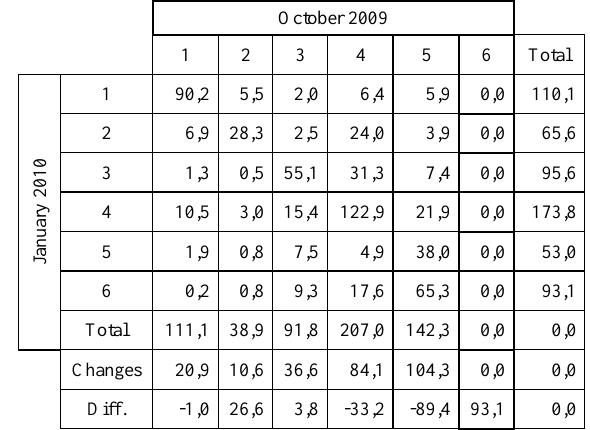
Table 16. October-January land use/cover changes matrix (km 2 ) From the comparison between the October 2009 and the